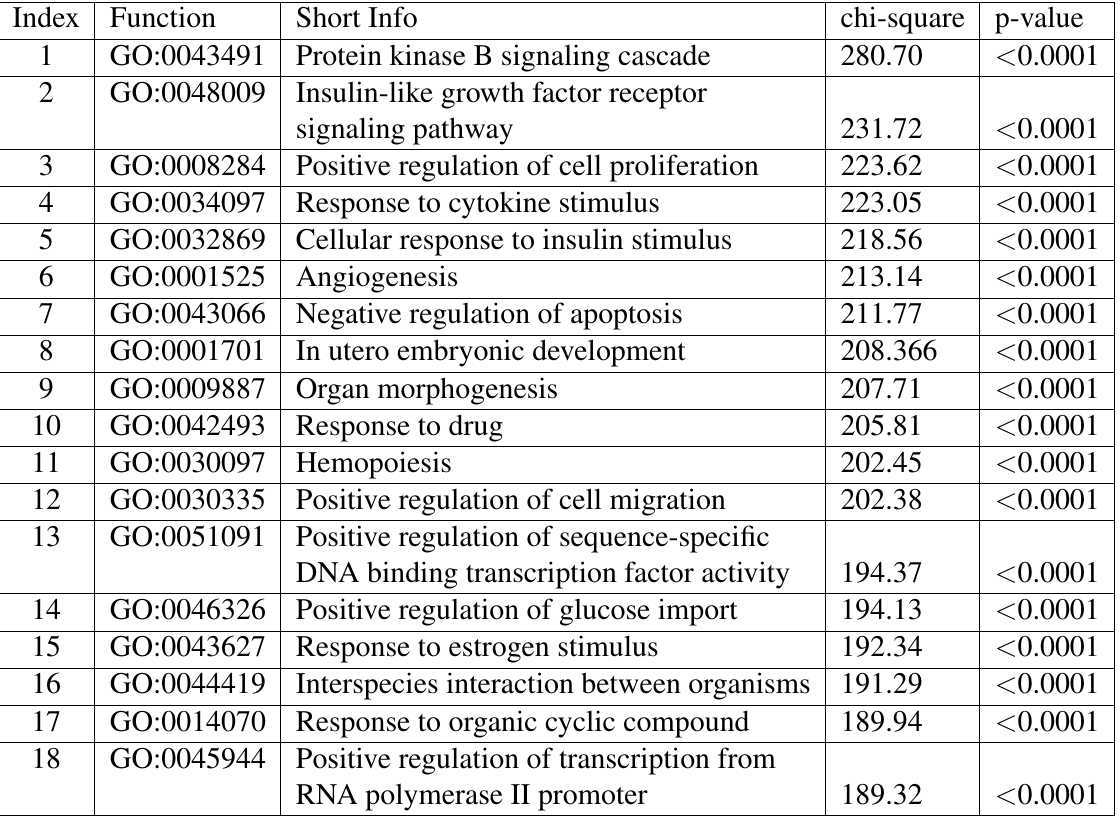
Table 6: Most discriminative functions from Biological Process based on FS + IFC